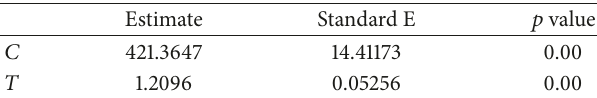
Table 2: Power law parameters